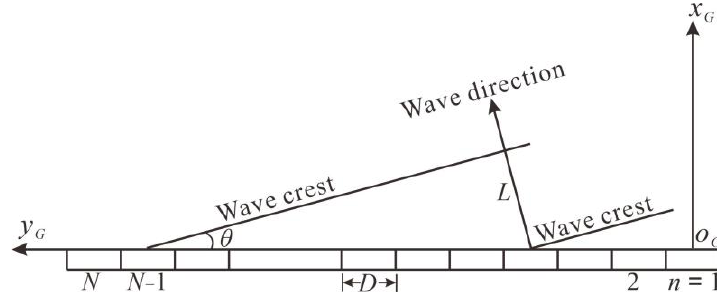
Figure 2. Sketch of the serpentine wave-maker in the global coordinate system.